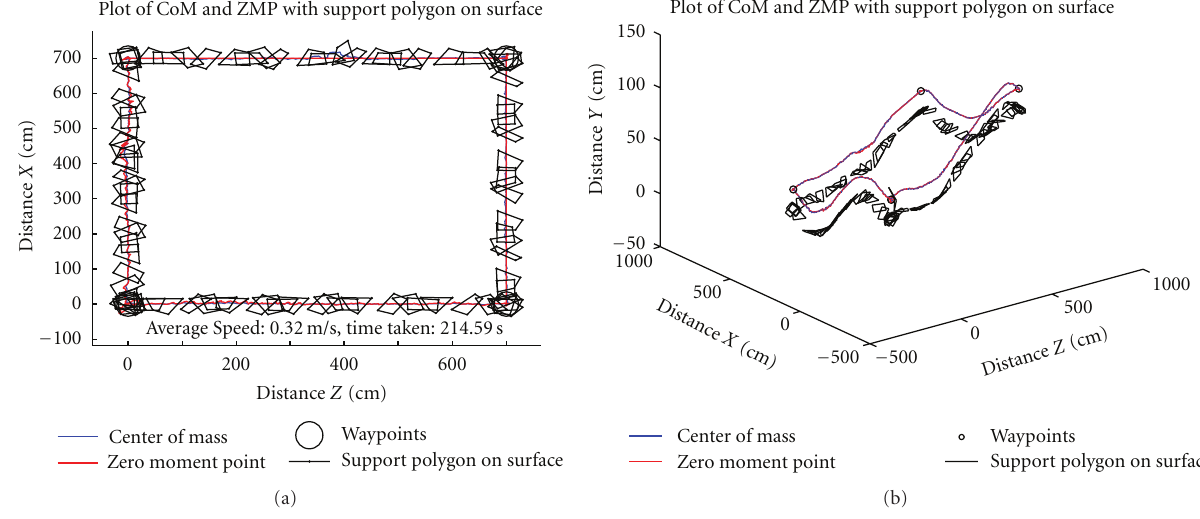
Figure 15: Plot of CoM and ZMP with SPOS using the proposed Foothold Reflex Control method.